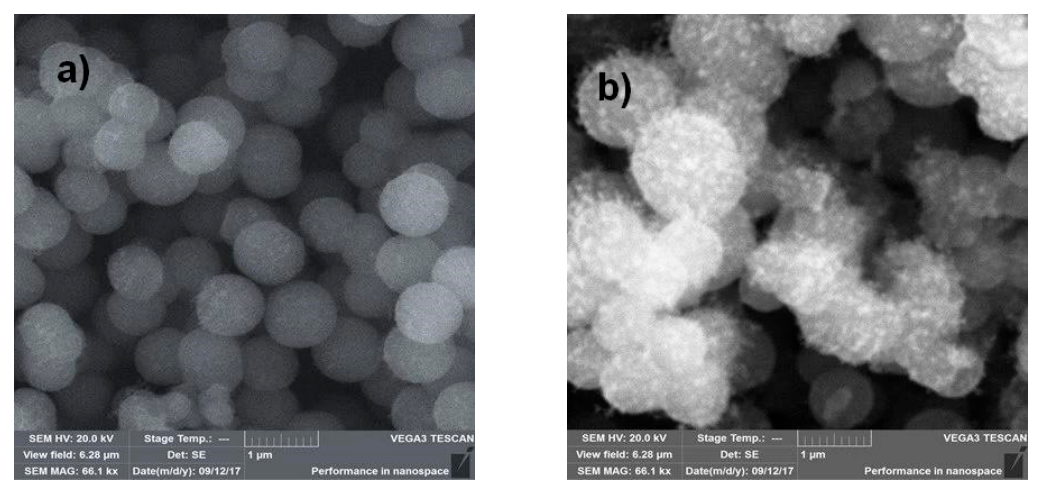
2 -C 3 H 6 -(30%)NH 2 and ( b ) 5 wt.% Pd